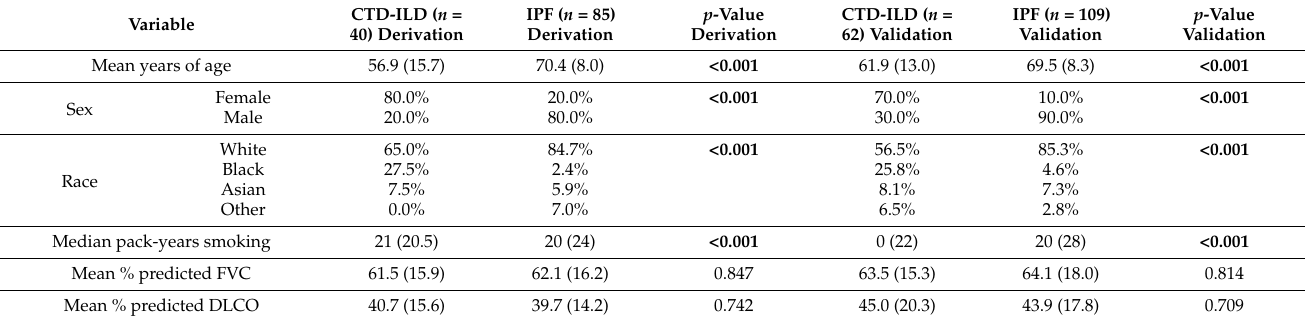
Table 1. Baseline characteristics stratified by diagnosis at two tertiary medical centers (labeled derivation and validation).